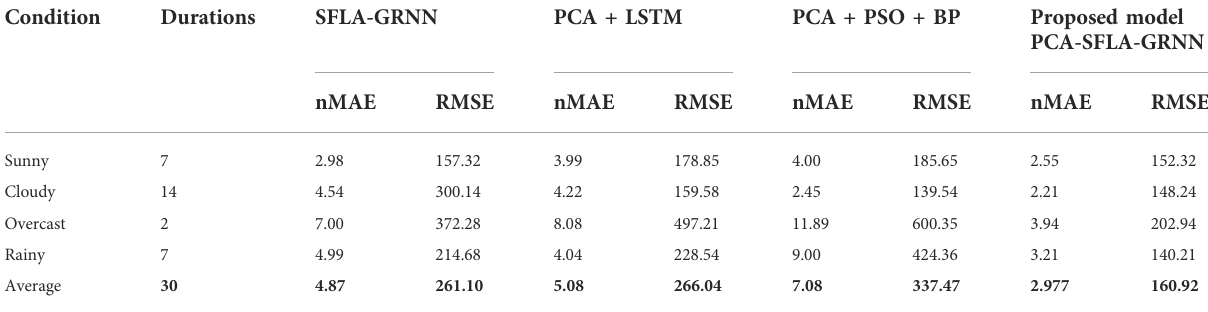
TABLE 4 Error in forecasting at different weather